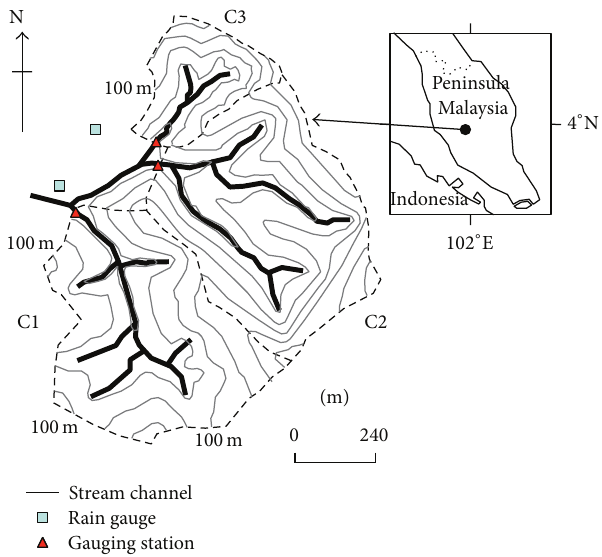
Figure 1: Bukit Tarek Experimental Watershed, Kerling,